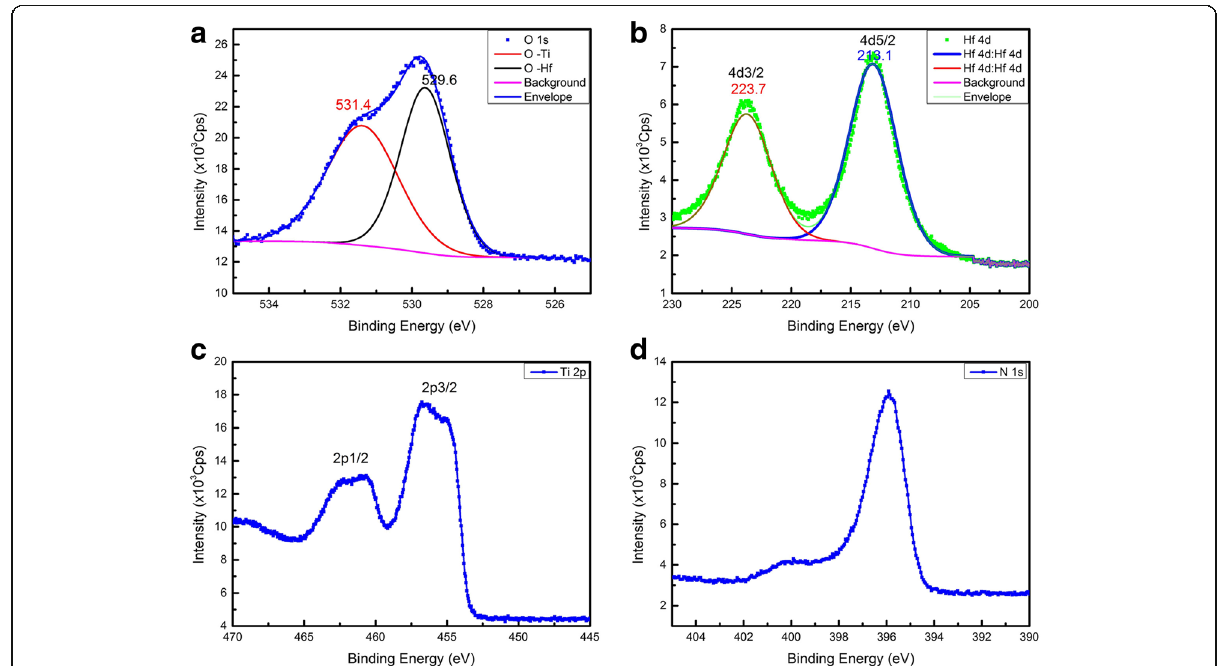
Fig. 2 XPS of HfO 2 /TiN structure. a O 1s spectrum. b Hf 4d spectrum. c Ti 2p spectrum. d N 1s